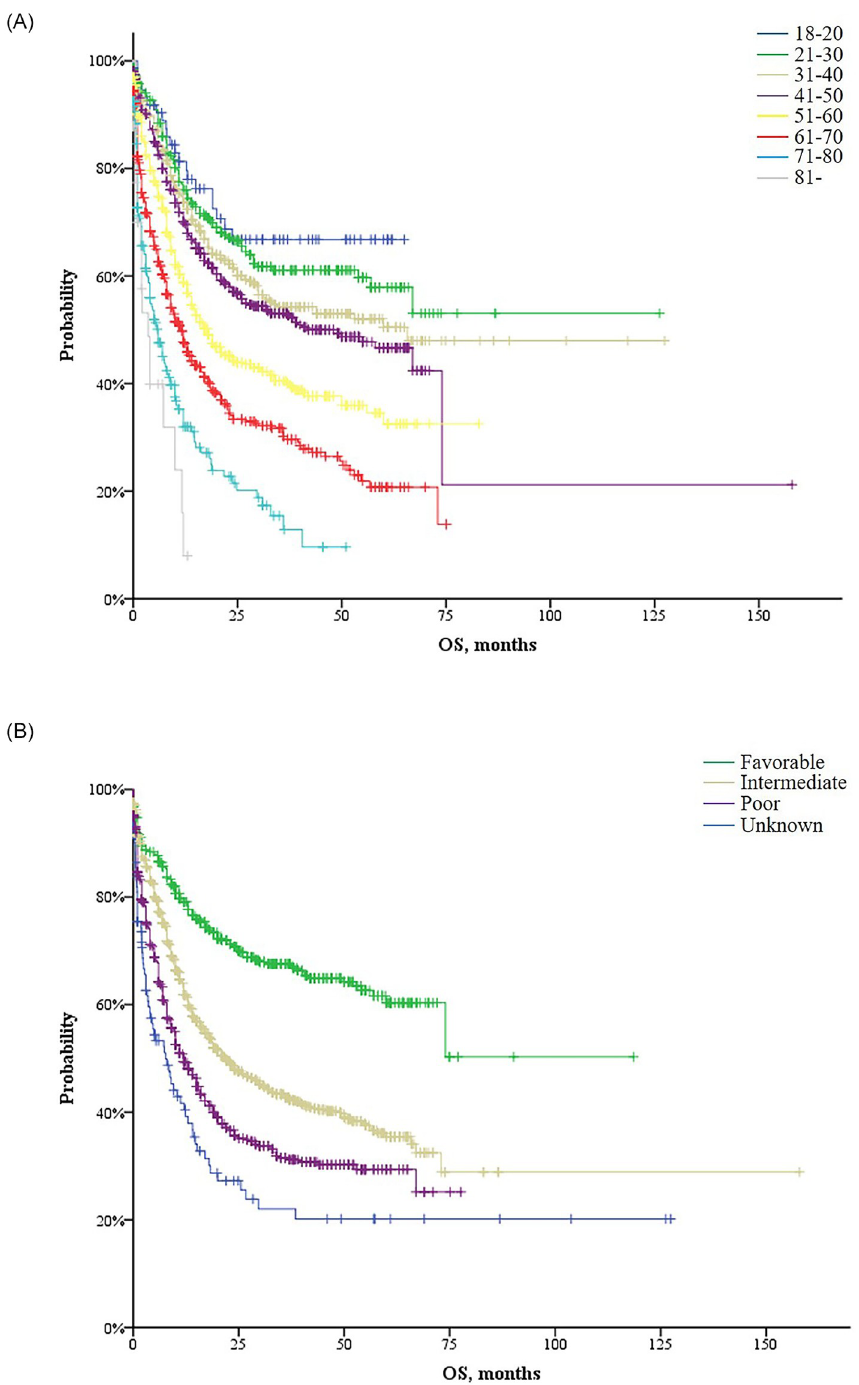
Fig 4. Overall survival (OS) of all patients (n = 3,011) according to age group (A) and cytogenetic risk (B).